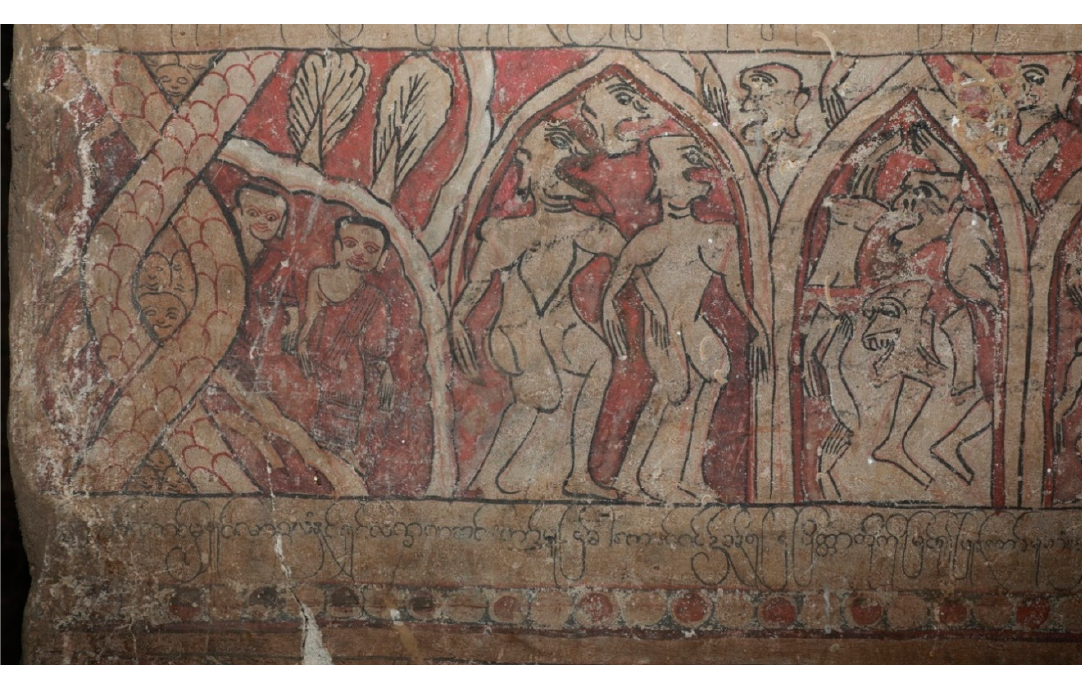
Figure 13. Pakhangyi, Endowment 227, late 18th century. Shin Mogalan and Shin Lakshana descend from the mountain. They see in the sky that there are ghosts and then they smile.